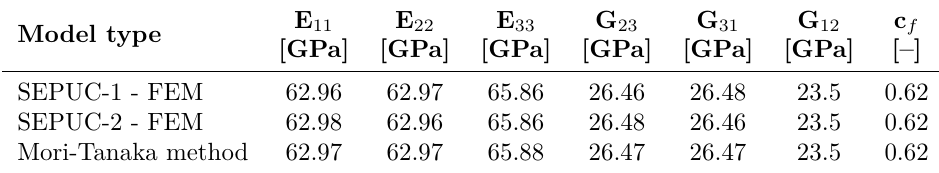
Table 3. Effective elastic moduli.